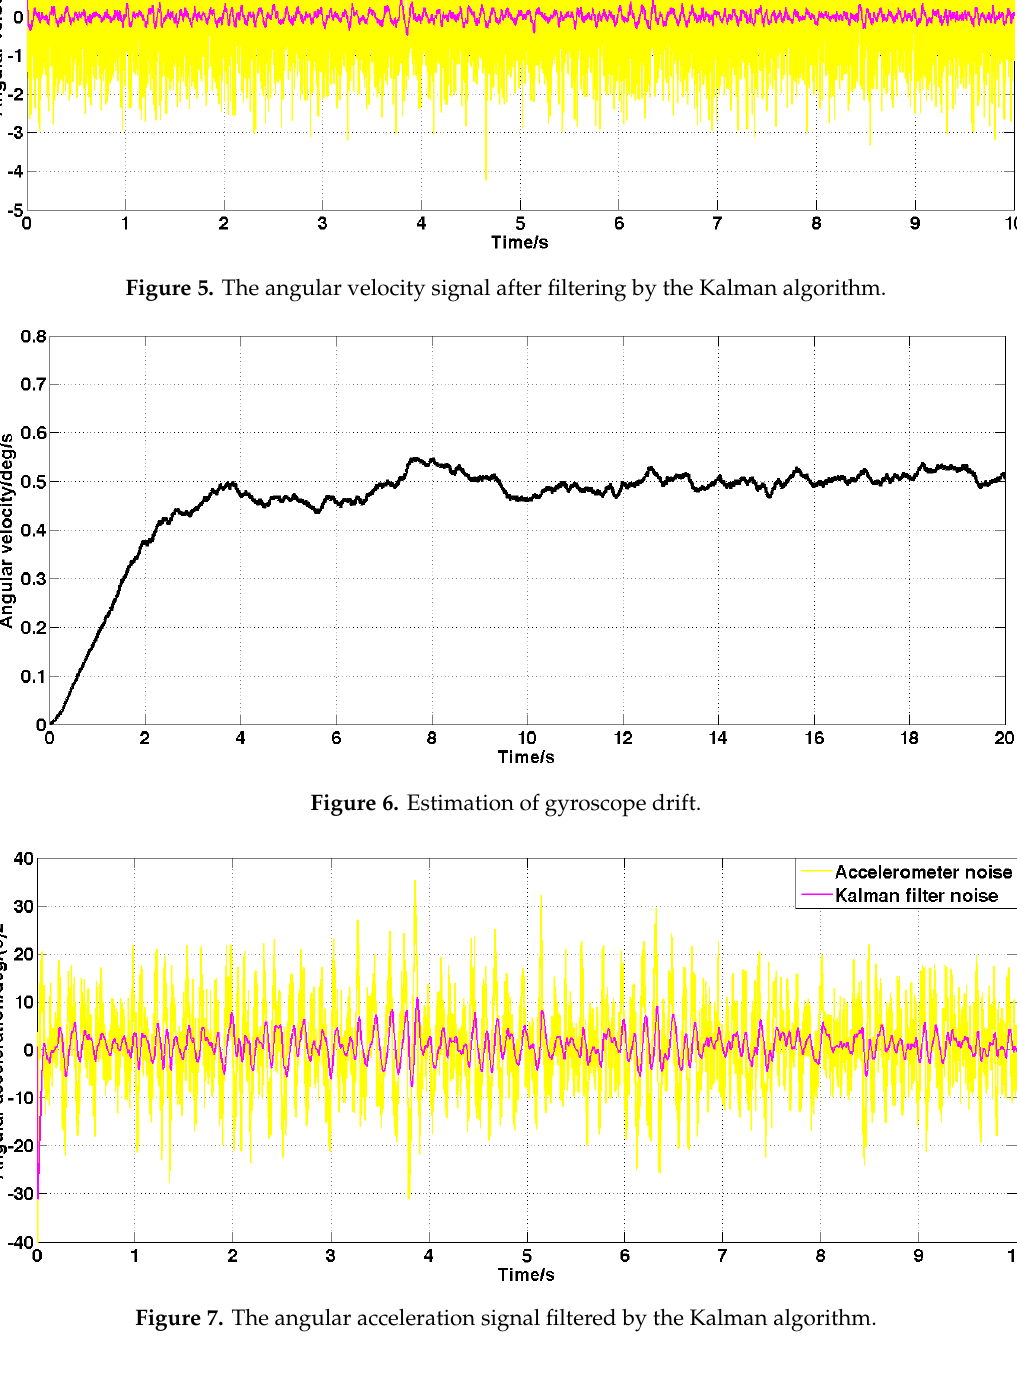
Figure 8. Estimation of accelerometer drift.